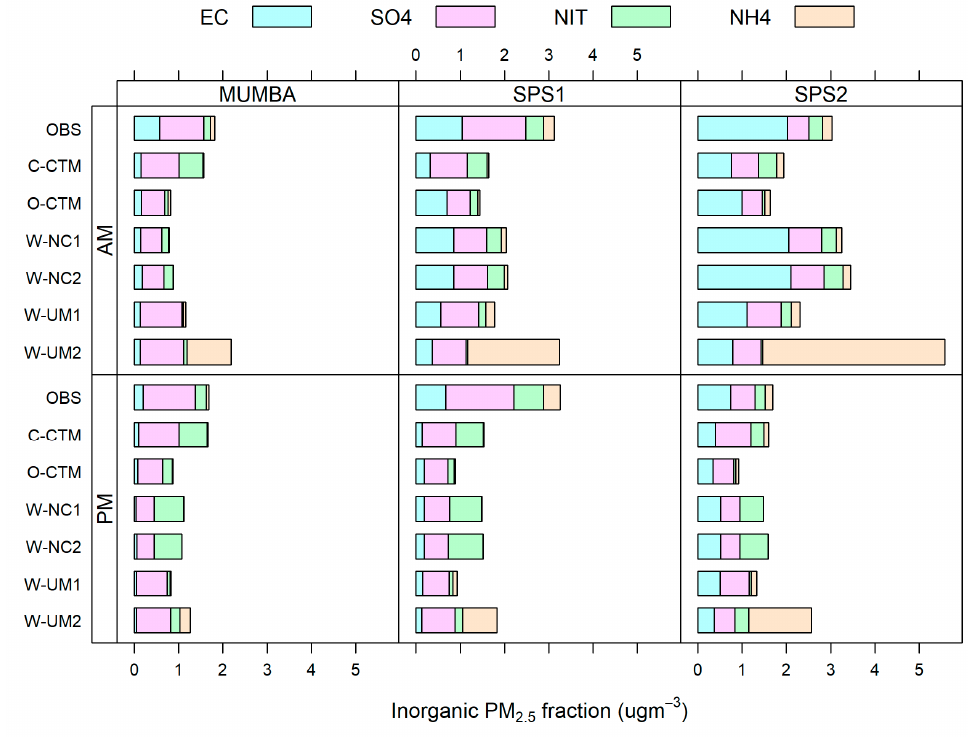
Figure 11. Median inorganic fraction of PM 2.5 in µ gm − 3 from morning (AM) and afternoon (PM) filters, coloured by its composite species: elemental carbon (EC), sulfates (SO 4 ), nitrates (NIT) and ammonium (NH 4 ).